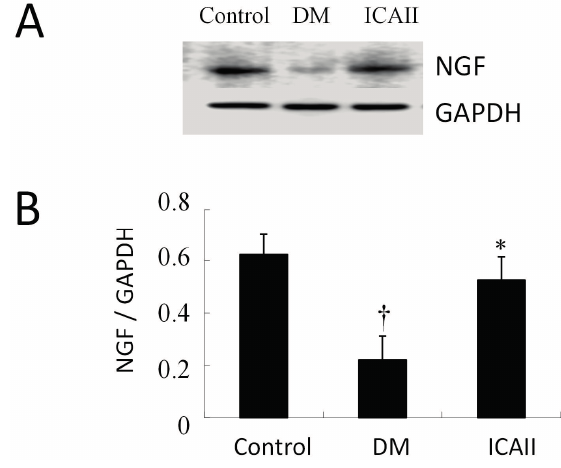
Figure 4. ICA II enhances NGF expression in the corpus cavernosum. ( A ) Western blot analysis of NGF expression in normal and diabetic rat corpus cavernosum; ( B ) Semi-quantitative analysis of NGF protein expression in testes with Western blot. † , * p < 0.01 in the ICA II-treated group compared with the Control and DM placebo group respectively.